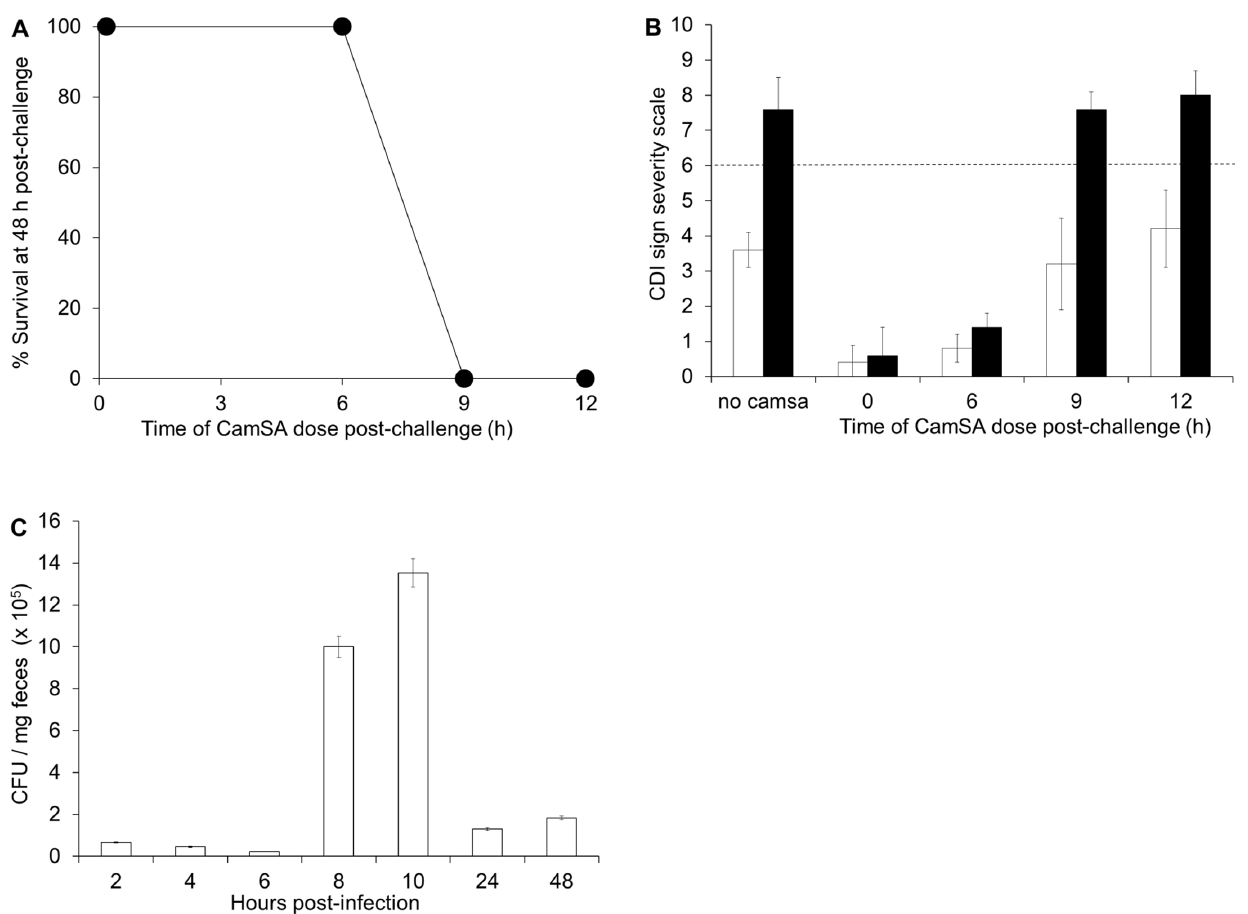
Figure 5. CDI is established between 6 and 9 hours post-infection. (A) Survival of infected mice at 48 hours after challenge with C. difficile spores. Mice were treated with 300 mg/kg CamSA at 0, 6, 9, or 12 hours post-challenge. (B) Comparison of CDI severity after 24 hours (white bars) and 48 hours (black bars) for animals challenged with C. difficile spores and treated with 300 mg/kg CamSA at 0, 6, 9, or 12 hours post-challenge. Clinical endpoint was set as . 6 in the CDI sign severity scale (dashed line). (C) C. difficile vegetative cell count in feces of untreated, diseased animals. Feces were collected from cages housing five untreated mice challenged with C. difficile spores. Open bars represent C. difficile vegetative cells. The amount of C. difficile spores excreted by untreated animals was negligible ( , 10% of vegetative cell counts). Standard deviations represent at least five independent measures. Recovered CFU and recovered spores represent mean values from pools of five animals.